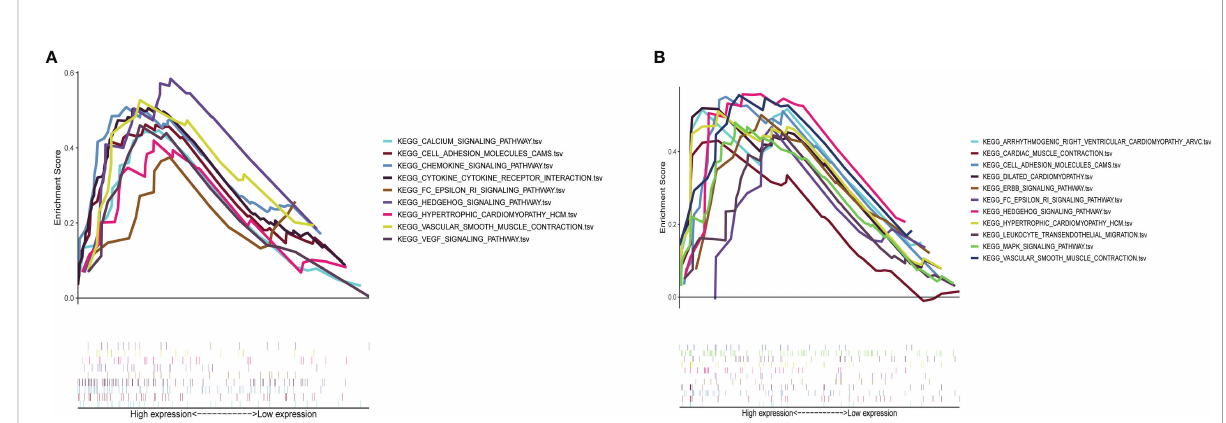
FIGURE 10 GSEA plot showing that a high expression of S100A8 and S100A9 is positively correlated with these signi fi cant signaling pathways. (A) In the group with high S100A8 expression in calci fi c aortic valve disease (CAVD), the enriched pathways included calcium signaling, cell adhesion molecules, chemokine signaling, cytokine – cytokine receptor interaction, FC epsilon RI signaling, Hedgehog signaling, hypertrophic cardiomyopathy, vascular smooth muscle contraction, and VEGF signaling. (B) In the group with a high expression of S100A9 in CAVD, the enriched pathways included arrhythmogenic right ventricular cardiomyopathy, cardiac muscle contraction, cell adhesion molecules, dilated cardiomyopathy, ERBB signaling, FC epsilon RI signaling, Hedgehog signaling, hypertrophic cardiomyopathy, leukocyte transendothelial migration, MAPK signaling, and vascular smooth muscle